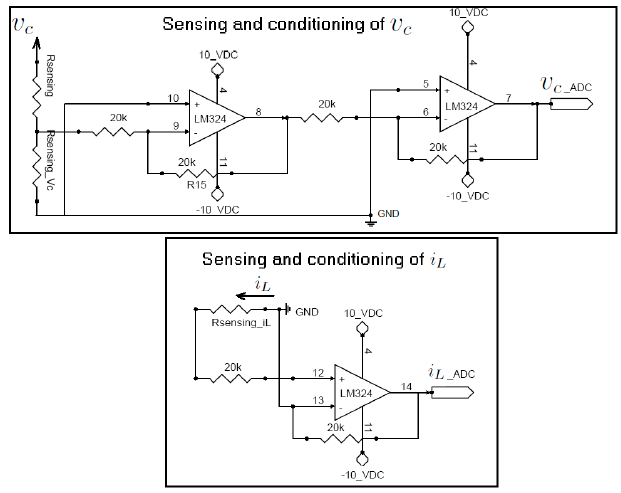
Figure 8. Sensing and adaptation of analog signals.